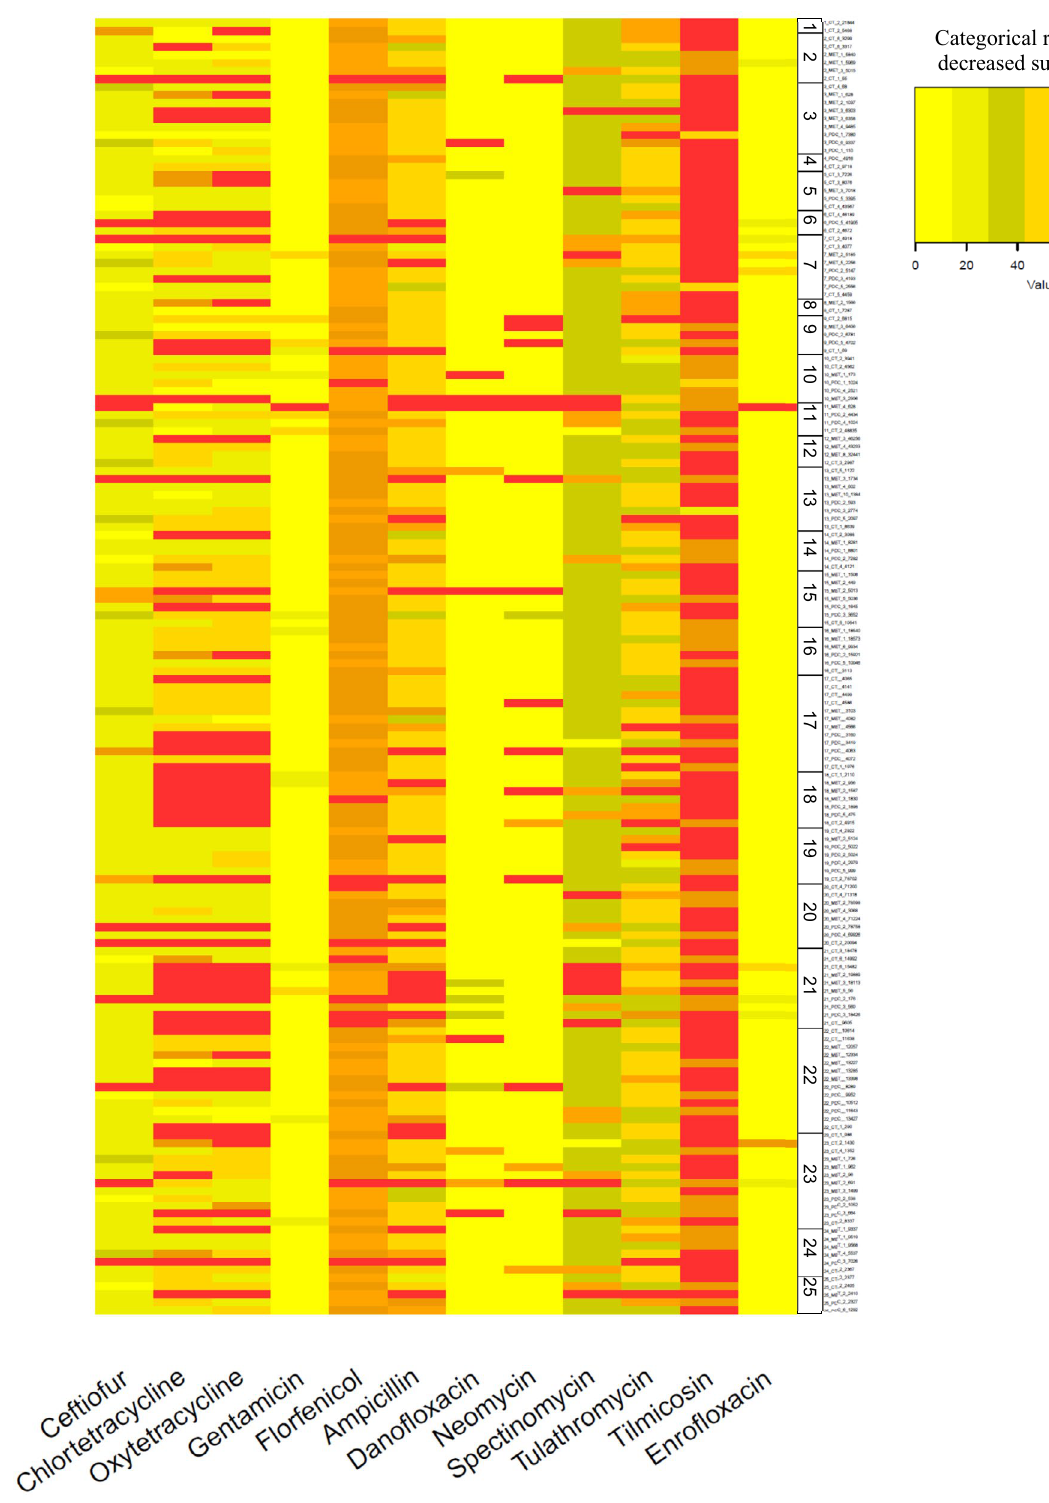
Figure 2. Heat map of MICs for 12 antimicrobials compared against 162 E. coli isolates grouped by the farm (n = 25). Each row represents an isolate that was categorized by percent decrease in susceptibility range. Boxed numbers indicate which of the 25 farms samples